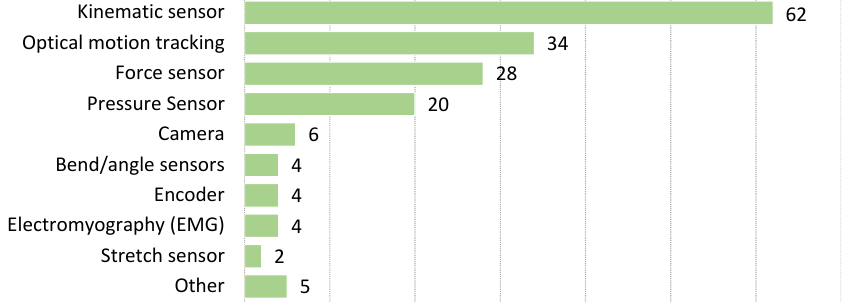
Figure 6. The number of studies using different sensors. Because some studies use more than one type of sensor, the total number is greater than the number of papers included in the review. Optical motion tracking is widely used in kinematic studies as the primary or vali- dation system. One type of commercial optical motion tracking system is used in 34 pa- pers. These include professional systems with markers as well as commercially available devices such as Kinect, which uses stereoscopic infrared vision for motion detection and tracking. Some studies (six) use video cameras, usually combined with another sensor. Other notable sensor types include bend or angle sensors, used in four studies, stretch sensors used in two studies, and angle encoders used in four studies. Although studies using electromyography would normally be excluded from our review, three pa- pers use it in conjunction with other sensors. One study uses it exclusively, but we con- sider this work important because it addresses other aspects of BMF. It is quite common for studies to use more than one type of sensor, but sometimes it is difficult to distinguish which sensors or which combination of them provides the input for the feedback. Table 2 lists all the sensors mentioned in the papers studied.